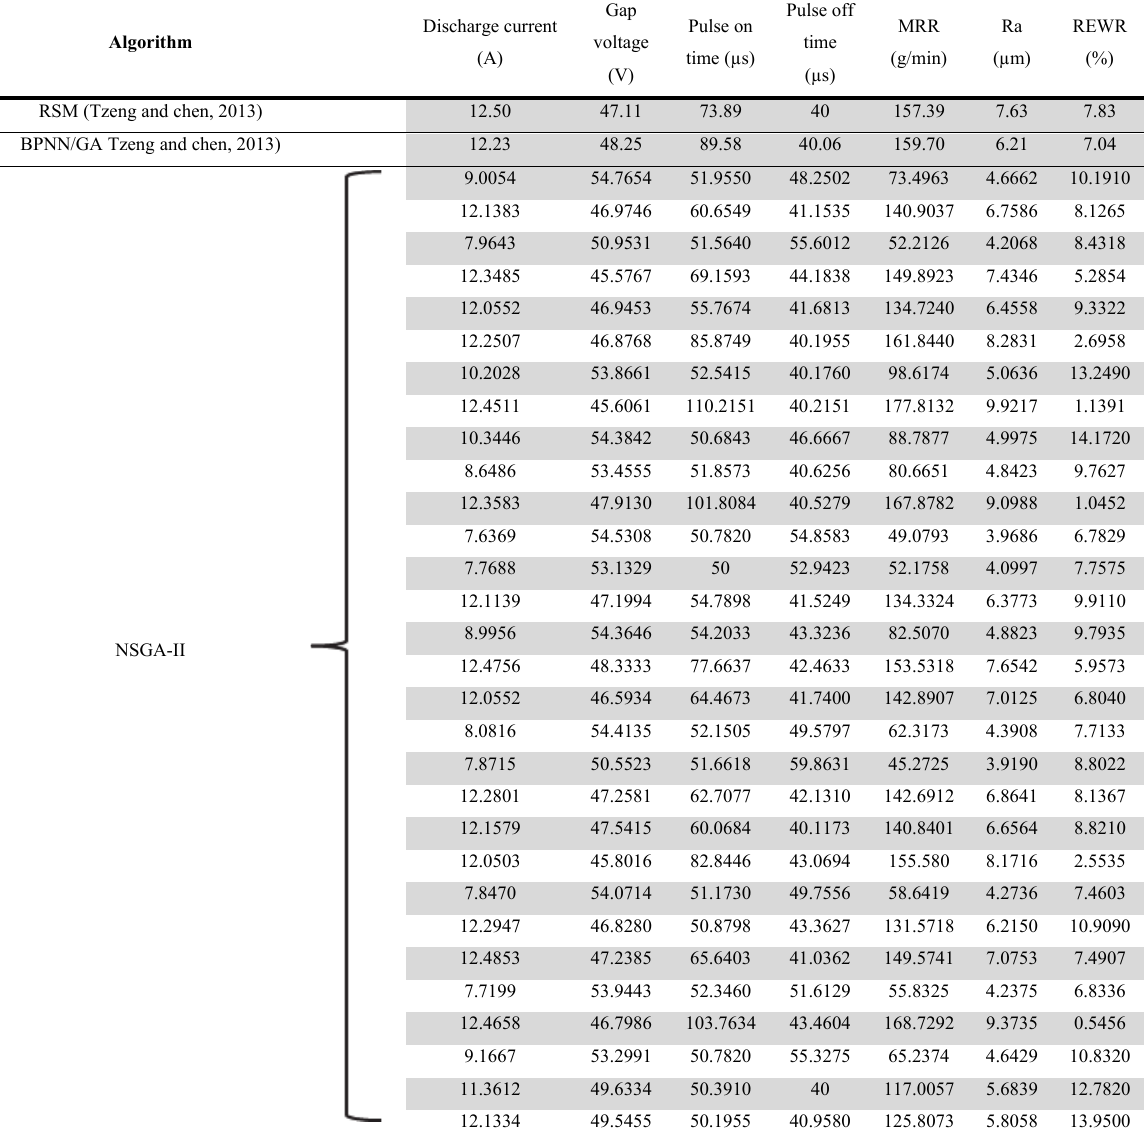
Table 3 Comparison of NSGA-II results for EDM process